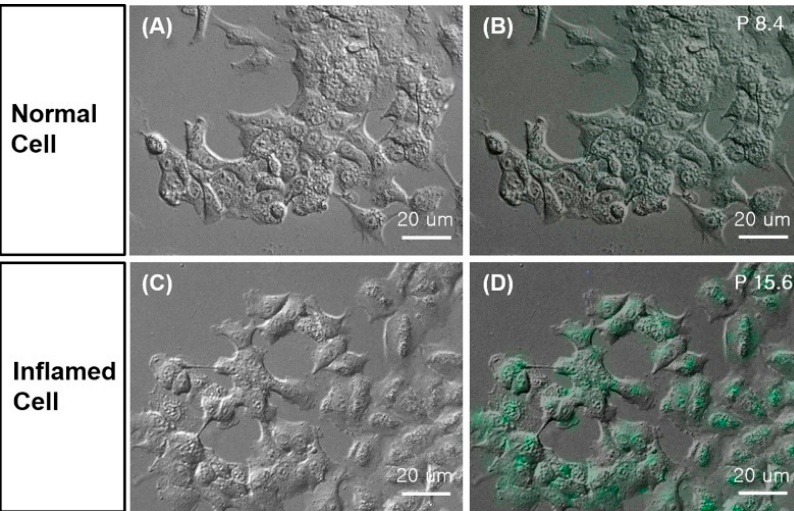
Figure 6. B1R inflammation imaging. After 1-day starvation, A549 cells were treated with 100 µg P. aeruginosa lysate for 4 h to induce inflammation. Cells were stained with 100 nM of FITC-conjugated Lys-[D-Phe 8 ]des-Arg 9 -BK for 1 h at 37°C and analyzed with optical imaging. Differential interference contrast (DIC) microscope image of ( A ) normal and ( C ) inflamed cells. Fluorescence and DIC merged images of ( B ) normal and ( D ) inflamed cells. Figure reproduced from Yeo, K.B.; et al. [75].